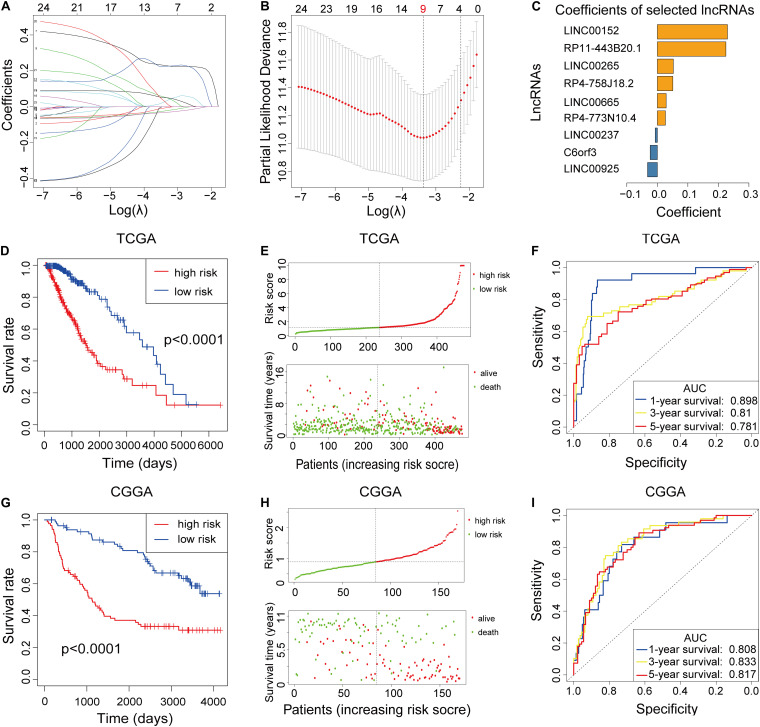
(A–C) Least absolute1 shrinkage and selection operator (LASSO) regression was performed, calculating the minimum criteria (A,B) and coefficients (C). (D) Kaplan–Meier curves showed that the high-risk subgroup had worse overall survival than the low-risk subgroup in The Cancer Genome Atlas (TCGA) dataset. (E) Distributions of risk scores [based on the m6A-related lncRNA prognostic signature (m6A-LPS)] and survival status of LGG patients in the TCGA dataset. (F) Receiver operating characteristic (ROC) curves of m6A-LPS for predicting the 1/3/5-year survival in the TCGA dataset. (G) Kaplan–Meier curves showing that the high-risk subgroup had worse overall survival than the low-risk subgroup in the Chinese Glioma Genome Atlas (CGGA) dataset. (H) Distributions of risk scores and survival status of LGG patients in the CGGA dataset. (I) ROC curves of m6A-LPS for predicting 1/3/5-year survival in the CGGA dataset.